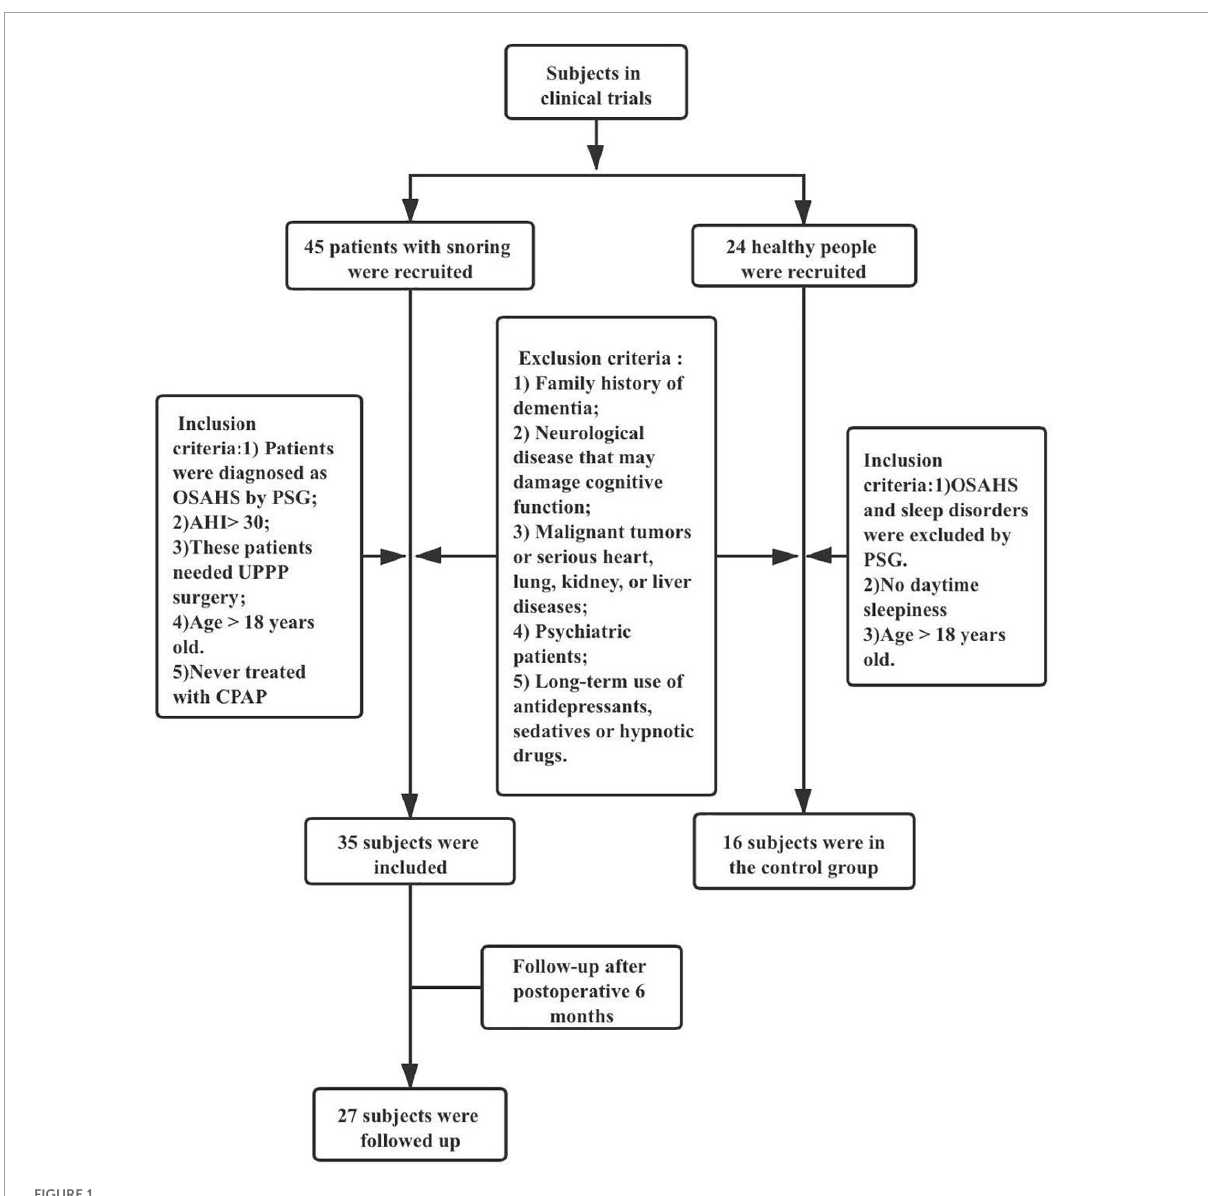
FIGURE1 Trial profile.